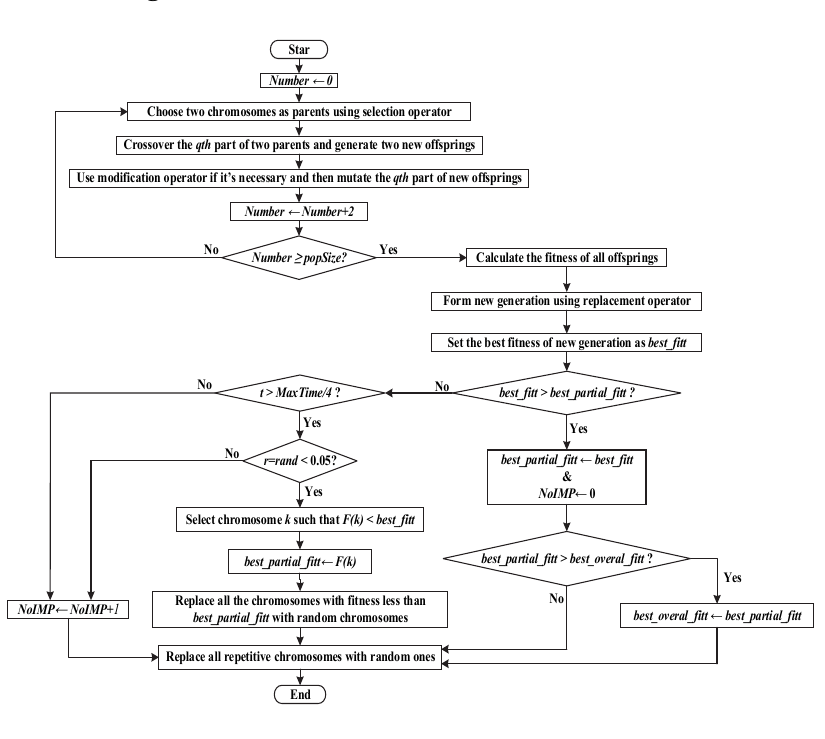
Fig. 5. Flowchart of HGA for the first and second parts of